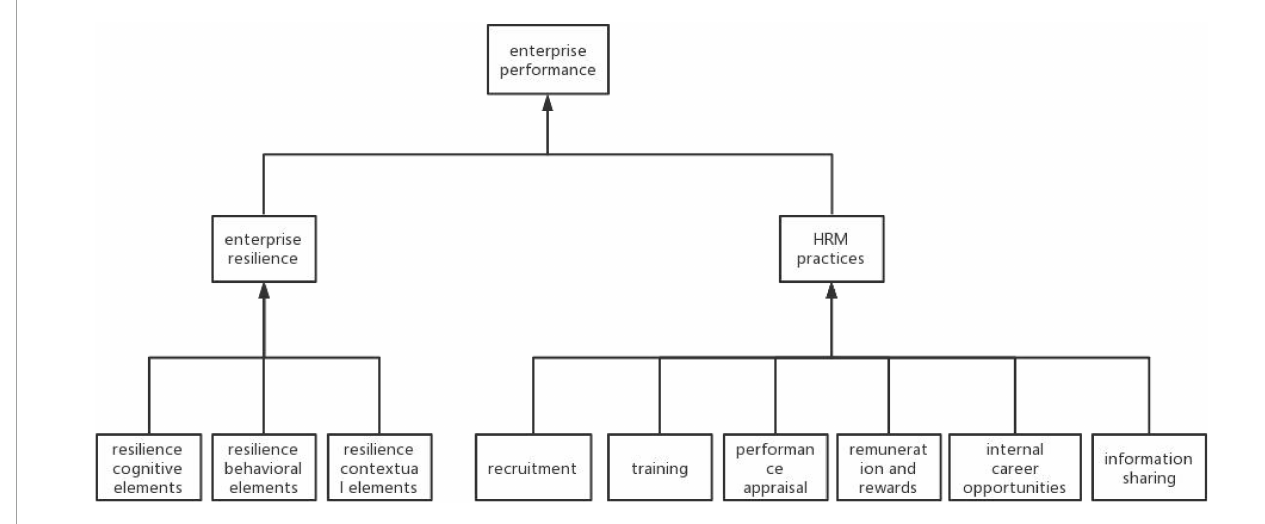
FIGURE1 The combined effect of enterprise resilience and human resource management (HRM) practices on enterprise